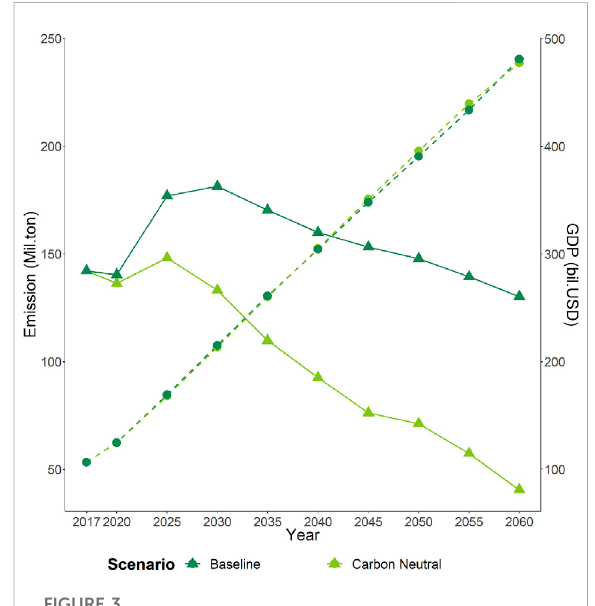
FIGURE 3 Carbonemissionsinthebaselinescenarioandcarbonneutral scenario in Gansu.